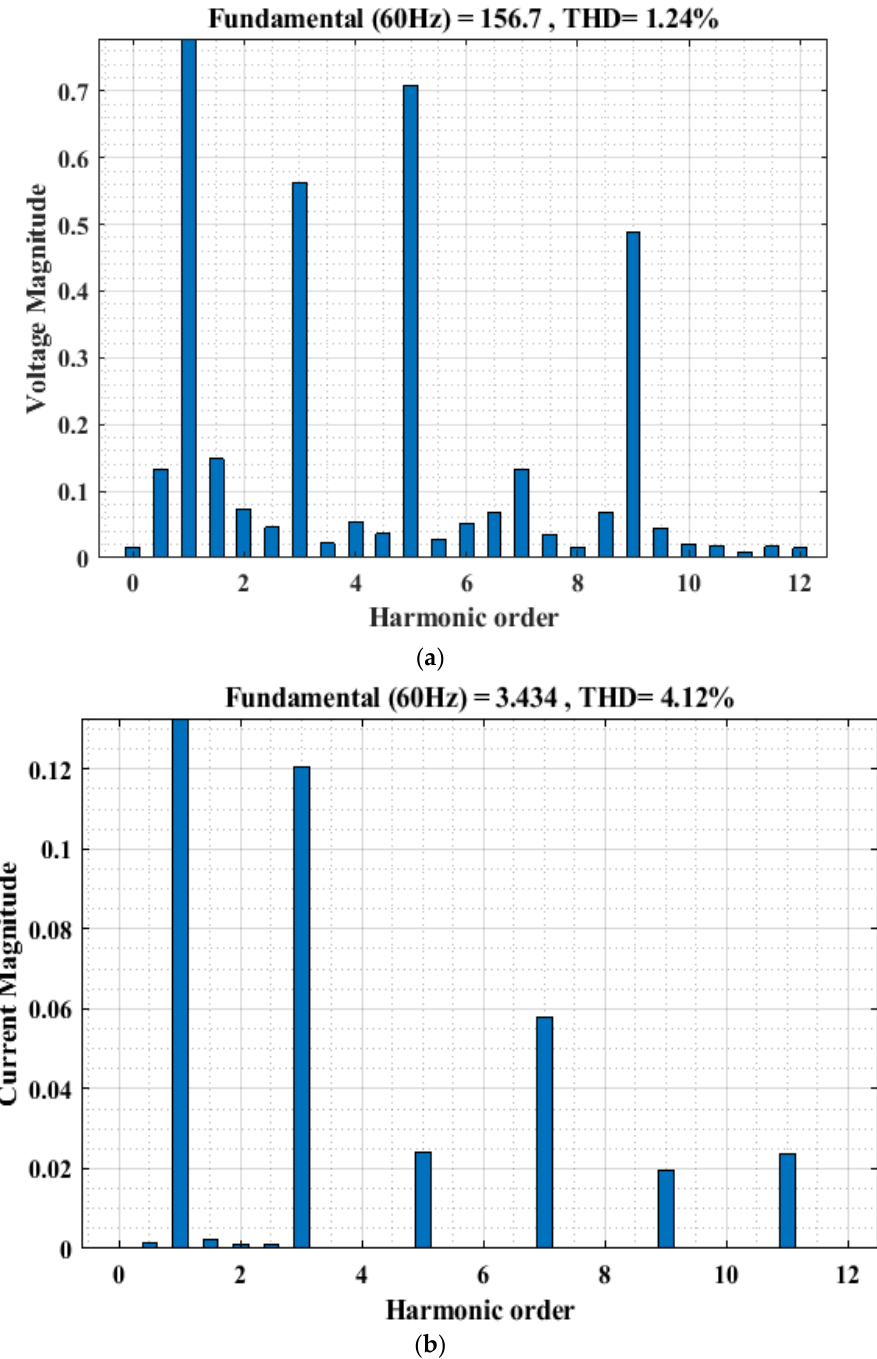
Figure 12. ( a ) FFT analysis for input voltage for induction motor load; ( b ) FFT analysis for current for induction motor load.